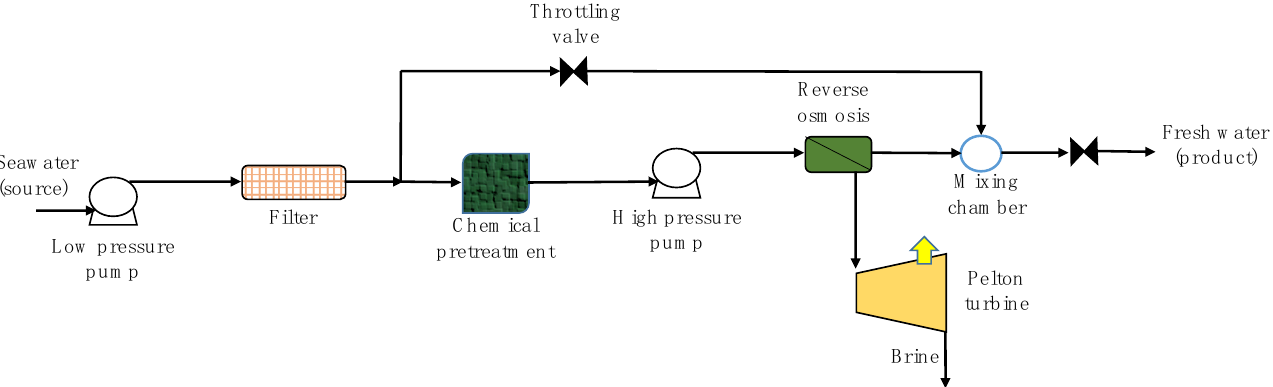
Figure 10. Schematic diagram of SWRO desalination plant with energy-recovery turbine. Based on El-Emam & Dincer [132].